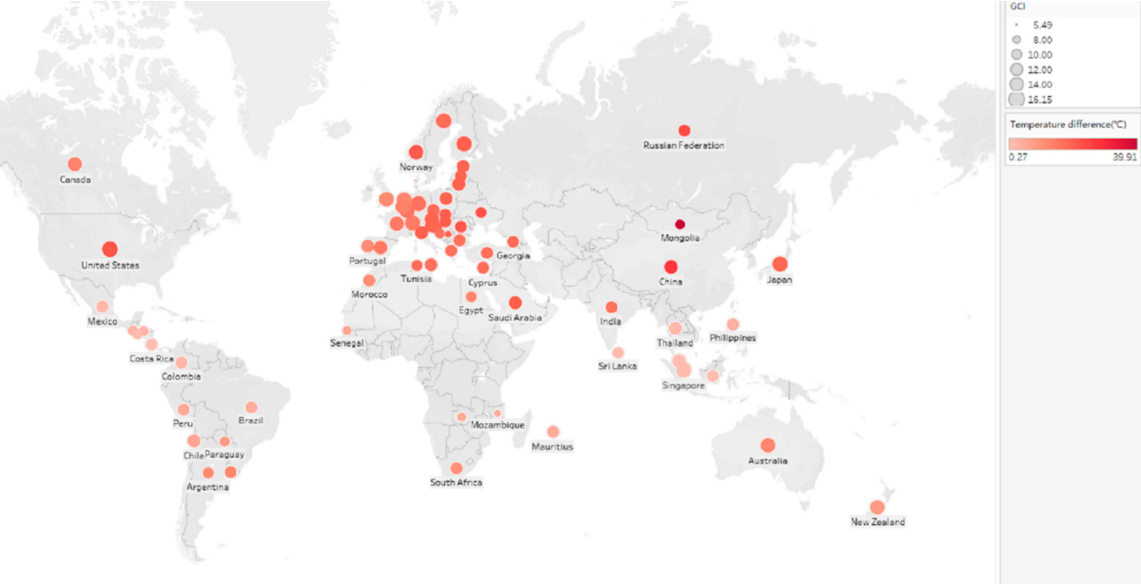
Figure 2. The impact of international competitiveness on temperature difference varies geographically.